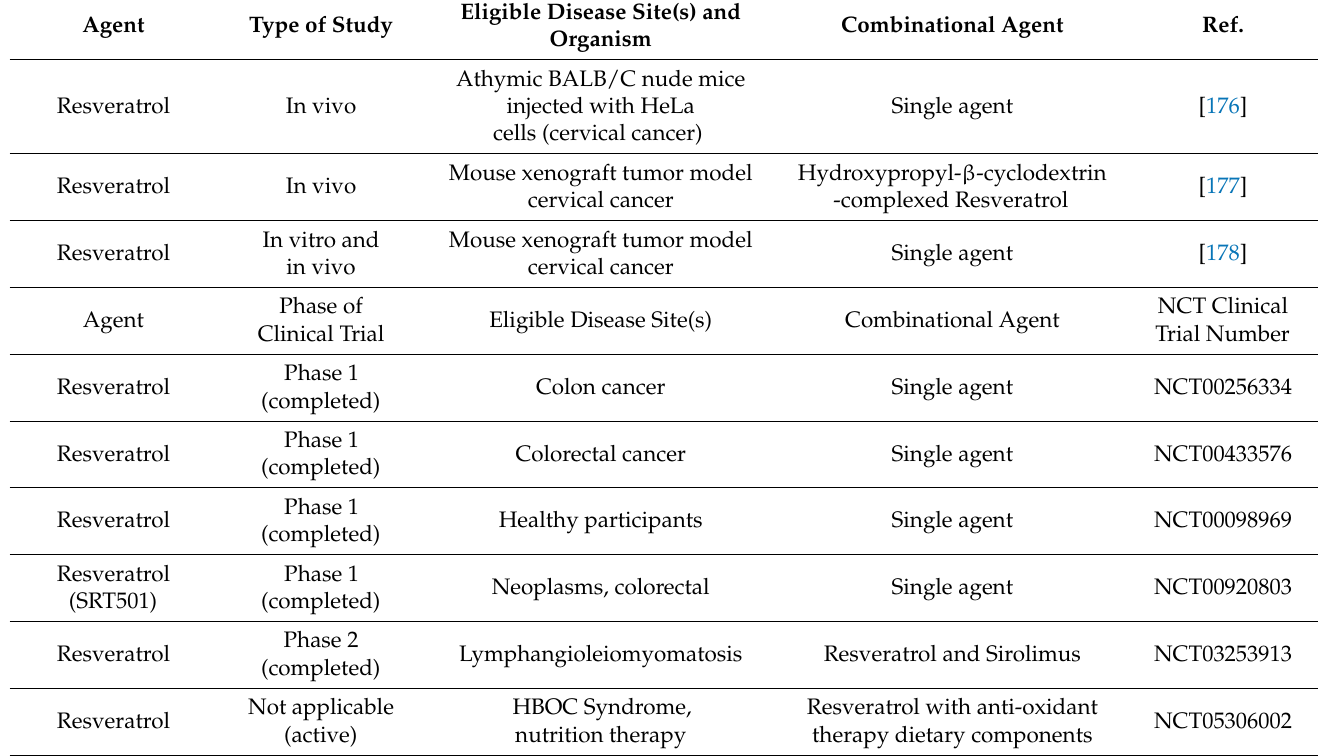
Table 4. Preclinical and clinical studies with